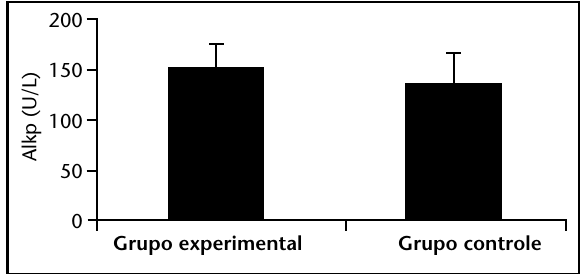
Figura 5 – Dosagens séricas de Alkp nos grupos experimental e controle Alkp: fosfatase